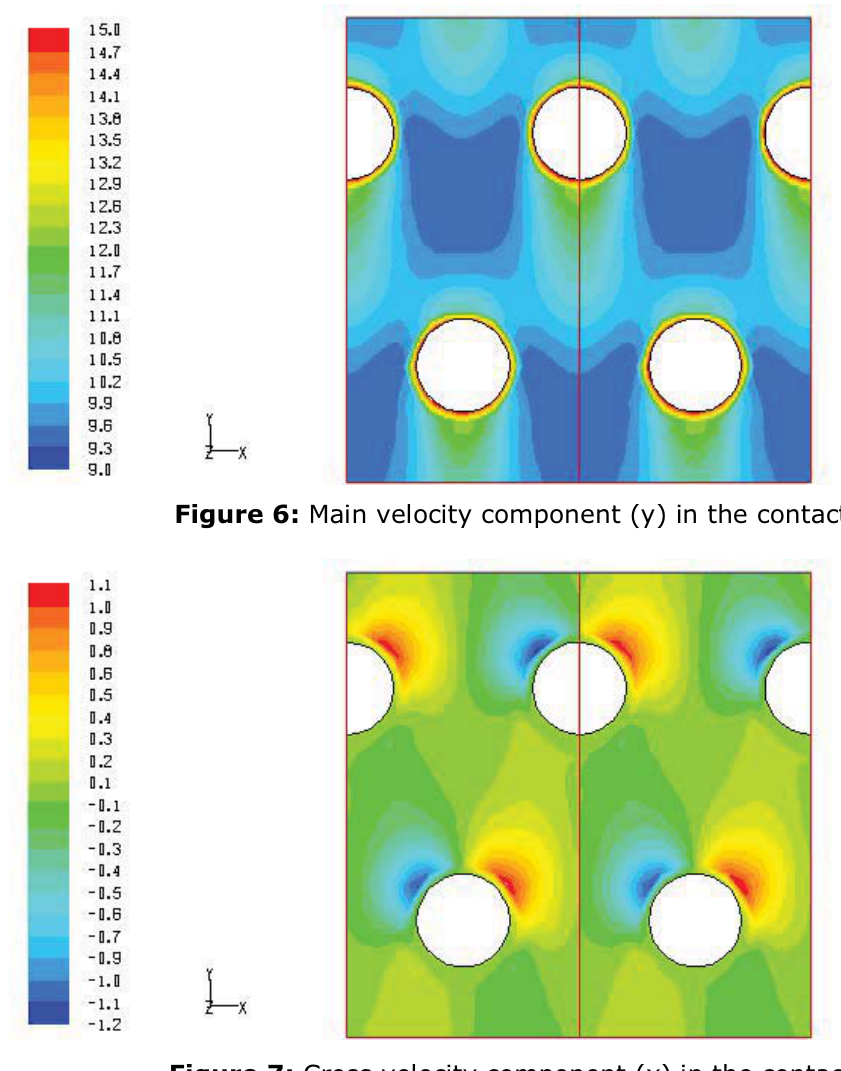
Figure 7: Cross velocity component (x) in the contact